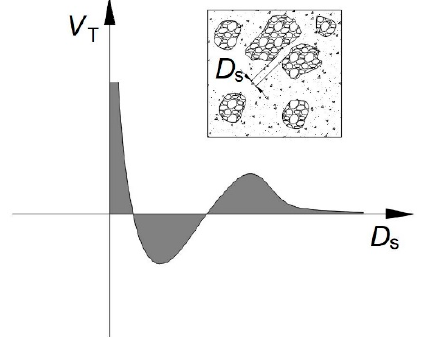
Figure 1. Total potential energy interaction V T between particles.